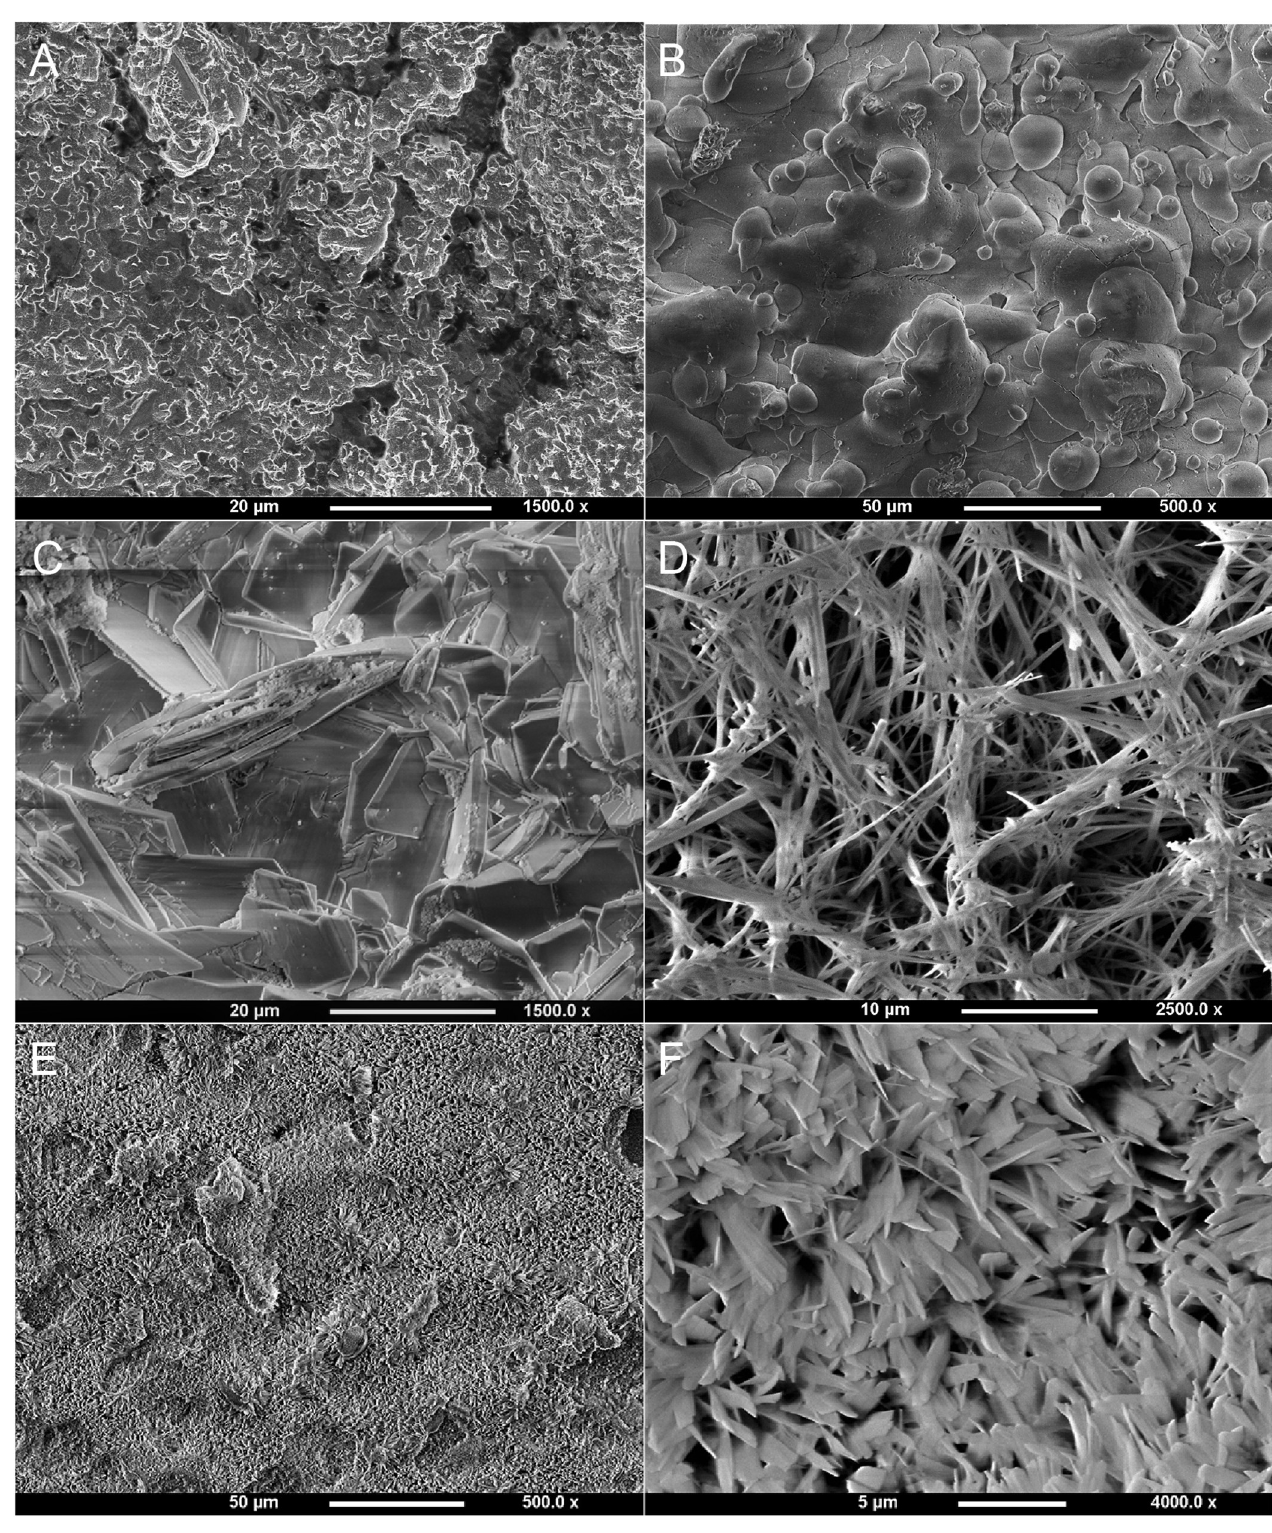
Fig 2. Surface morphology of Ti6Al4V discs with different coatings. (A) Uncoated, roughened, acid-etched. (B) Plasma-sprayed. (C) Electrochemically deposited HA. (D) Electrochemically deposited SiHA. (E-F) Electrochemically deposited SrHA.